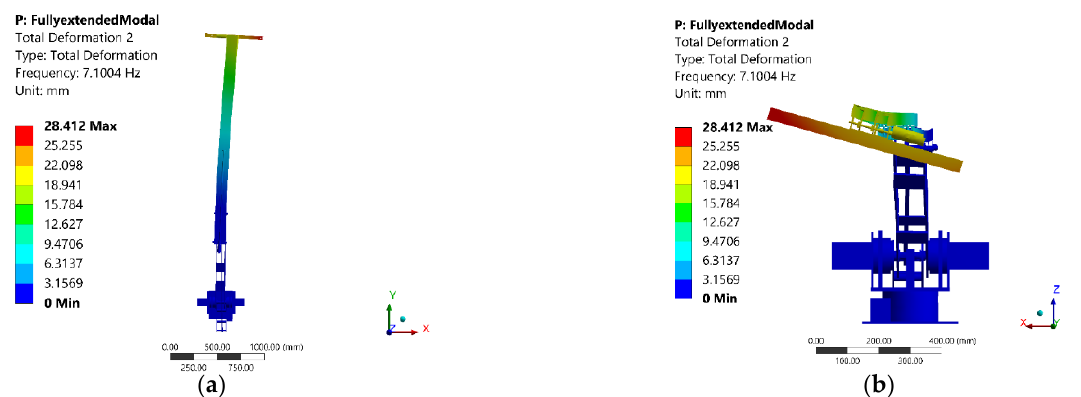
Figure 6. The 1st mode shape of vibration for the Fully-extended configuration, arm is fixed at the base ( a ) side view & ( b ) front view.